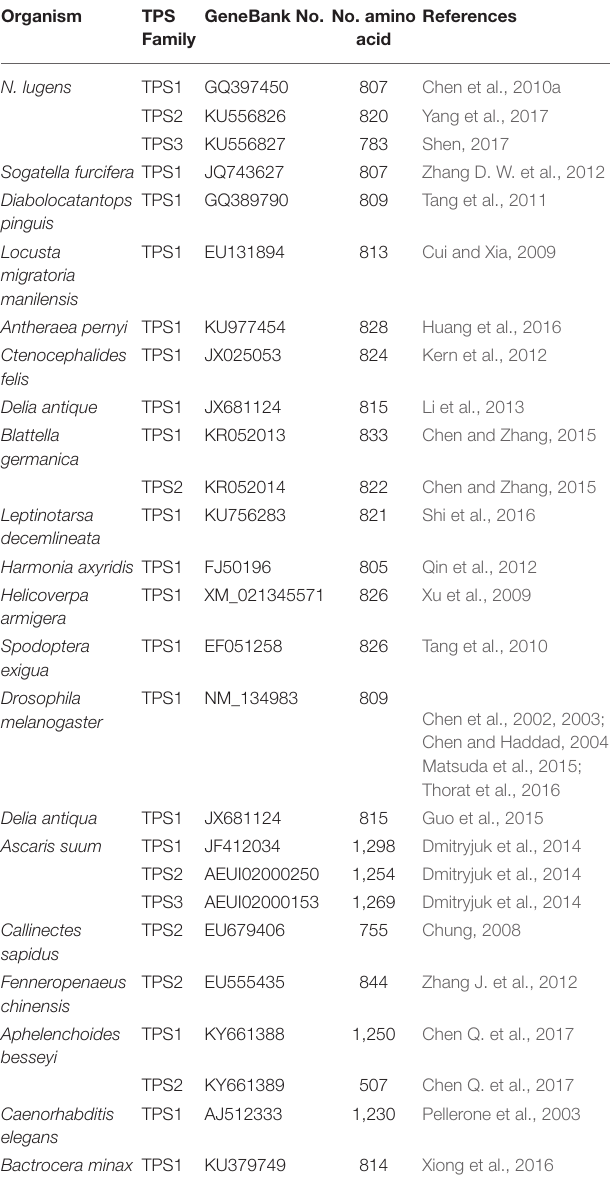
TABLE 1 | Characteristics of reported invertebrate TPS gene and their encoding protein.